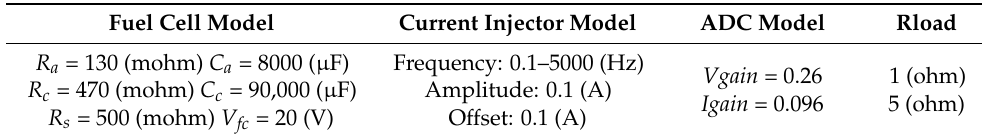
Table 2. Simulation values of parameters in Simulink